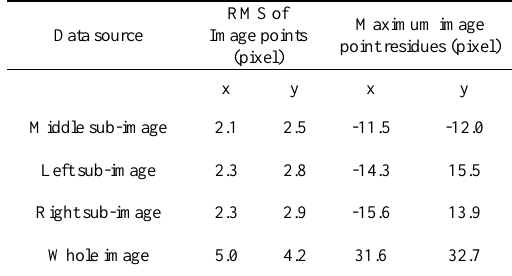
Table 2 Image point residues of bundle block adjustment with sub-images acquired by the left, middle, right sub-images and the whole image mosaicked by the three sub-images